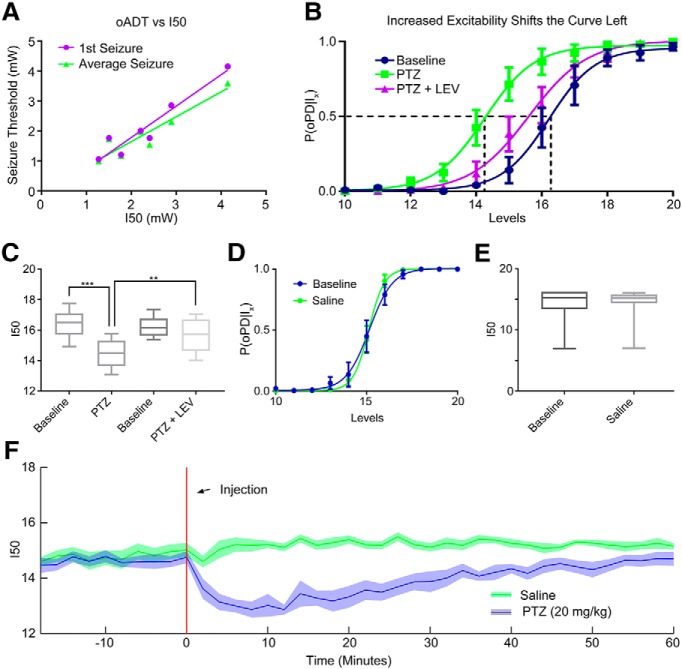
The I50 is sensitive to changes in network excitability. A, The relationship between pre-seizure I50 and the 1st oADT (purple) or the average oADT throughout 15 kindling sessions (green). B, C, The GABAa antagonist PTZ (20 mg/kg) shifts the oPD curve leftward and treatment with the anticonvulsant drug LEV (40 mg/kg) partially reverses the shift; n = 6 animals; ***p = 0.00043, **p = 0.0034. Curve error bars indicate the 95% CI. D, E, Handling and intraperitoneal saline administration did not significantly shift the oPD curve compared to baseline (paired t test, n = 7). F, I50 measurements reveal the time course of PTZ-induced hyperexcitability (disinhibition). Plot of the I50 over time. Six block bins, n = 9 presentations of each condition (three trials × three animals). Shaded area is mean ± 95% CI.